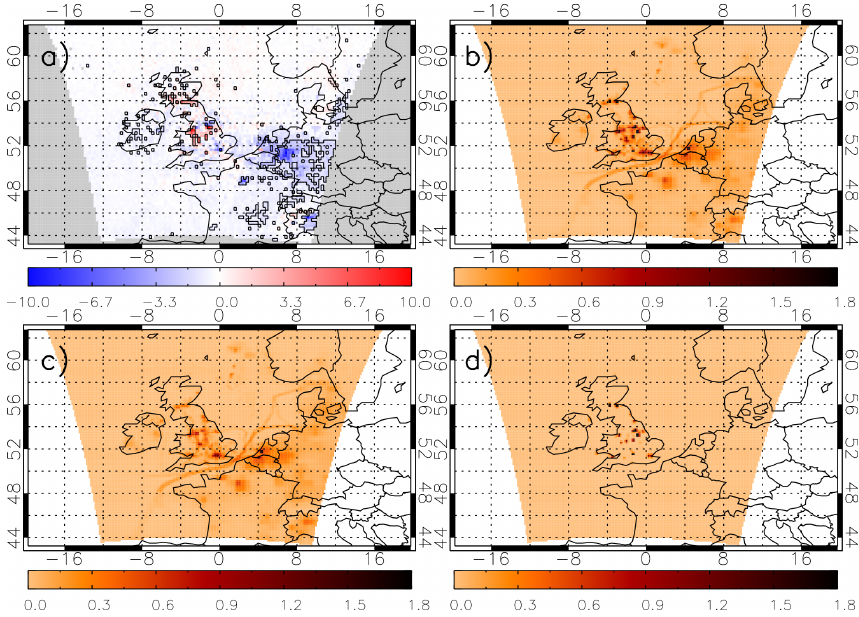
Figure 7. AQUM Run C (AKs applied)–OMI tropospheric NO 2 column ( × 10 15 moleculescm − 2 ) JJA 2006 mean bias. These are the control MBs to compare to the point source sensitivity experiments (RMSE = 3.64 × 10 15 moleculescm − 2 and FGE = 0.66). NO x